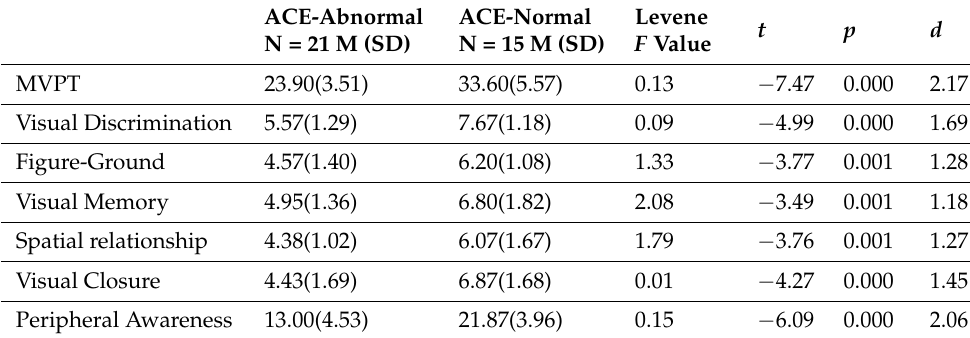
Table 4. t -test analysis of visual perception between ACE-normal and -abnormal groups.